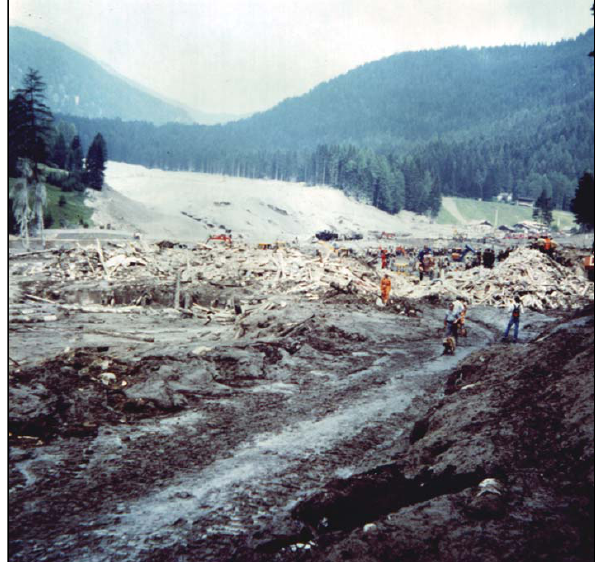
Fig. 10 ‐ Area where Stava village once stood. The mudflow in this urbanized sector reached a maximum height of 14 m in the middle of the valley bottom; all buildings were destroyed at the ground level. The mud ‐ covered Pozzole slope (Fig. 6) is visible in the upper left side of the picture (photograph CNR ‐ IRPI Torino, July 20, 1985).